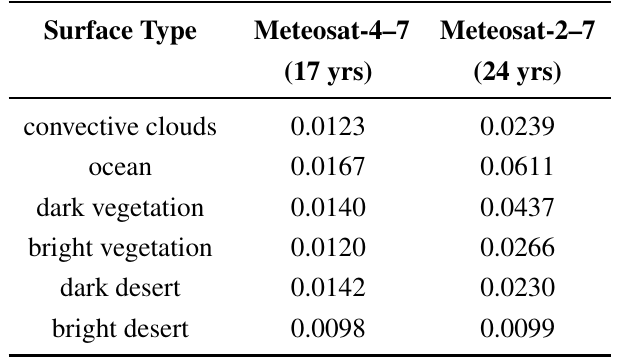
Table 8. The standard deviation of each full MFG time series for the Meteosat-4 up to 7 time series in the first column, and the Meteosat-2 up to 7 time series in the second